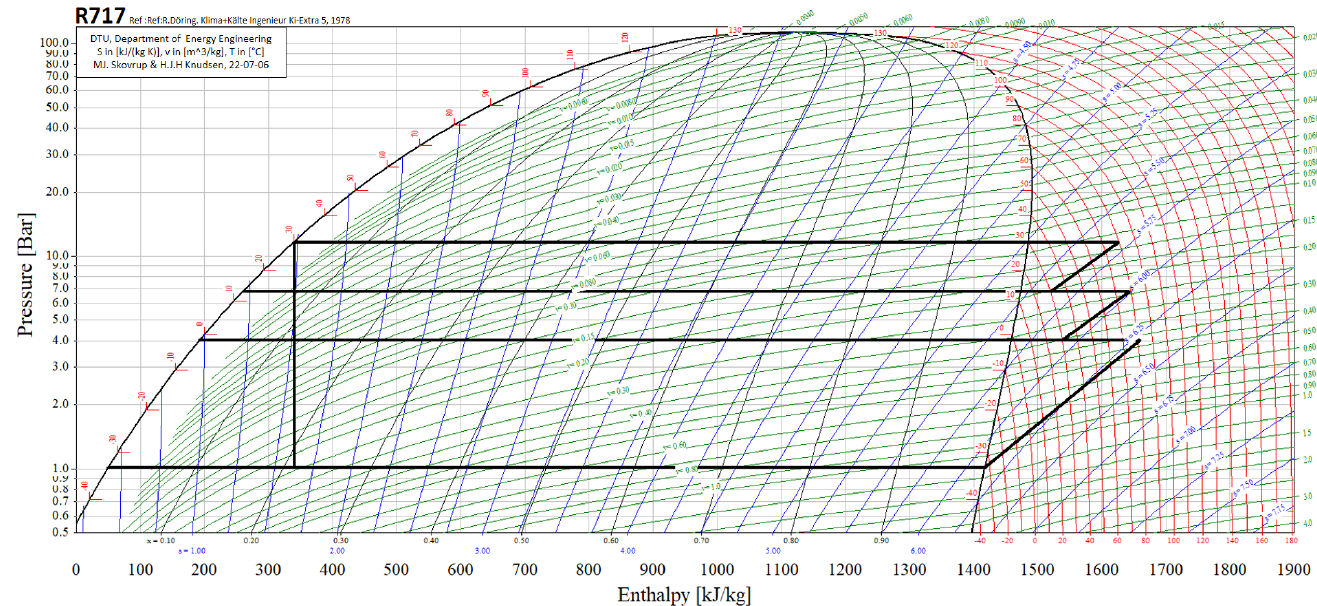
Figure 15. P – H diagram ammonia from 0.5 bar to 100 bar. The black lines illustrate the ammonia refrigeration cycle in configuration 3.